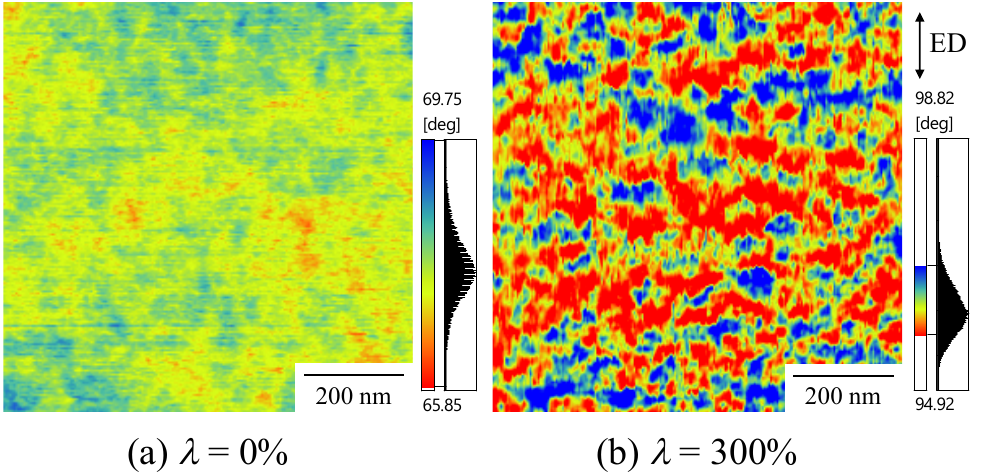
Figure 5. AFM phase images: ( a ) quenched TPU film ( λ = 0%), ( b ) heat-elongated TPU film ( λ = 300%).